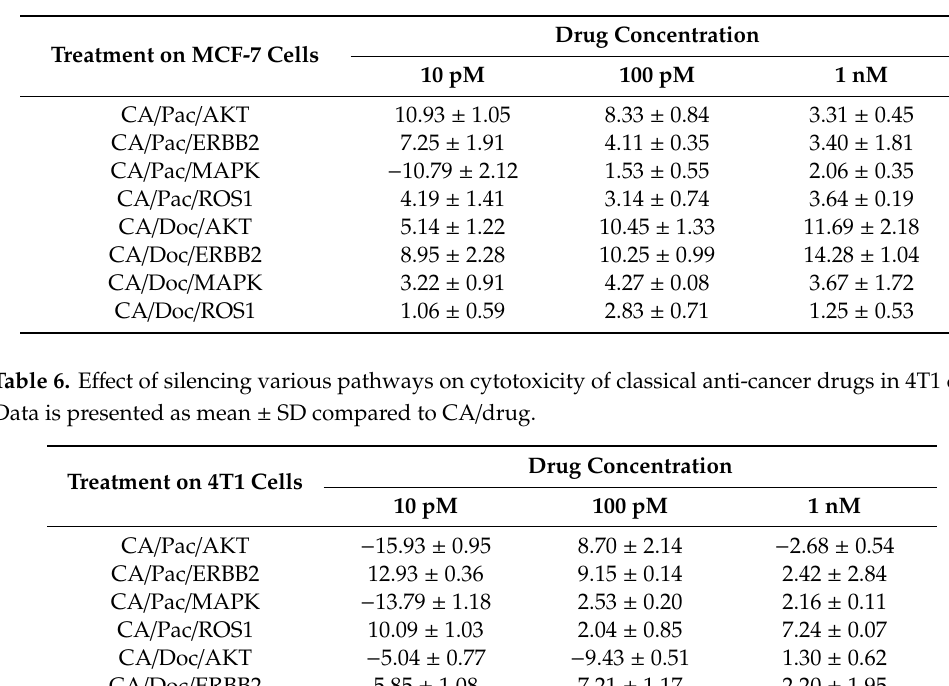
Table 5. E ff ect of silencing various pathways on cytotoxicity of classical anti-cancer drugs in MCF-7 cells. Data is presented as mean ± SD compared to CA / drug.